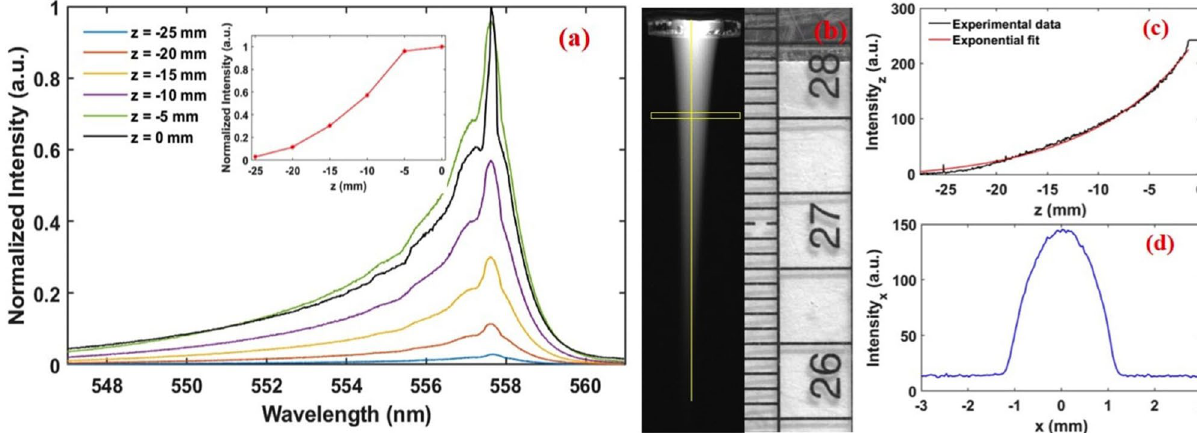
Figure 4. ( a ) Normalized emission spectra of O( 1 S) at different locations within the plasma plume. Inset shows maximum intensity variation with respect to vertical position with z = 0mm corresponding to the glass nozzle. ( b ) Typical image of the plasma jet taken from CCD camera. ( c ) The pixel intensity corresponding to the yellow vertical line shown in ( b ). ( d ) The pixel intensity extracted from the region between the horizontal box shown in ( b